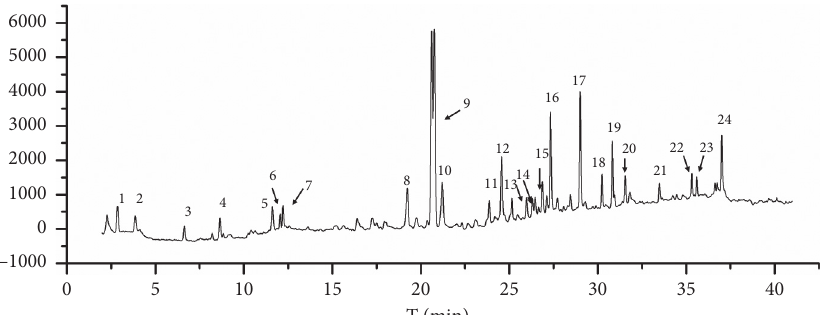
Figure 1: Chromatogram (captured at 360nm) of NBWE-1 captured using ultrahigh-performance liquid chromatography.